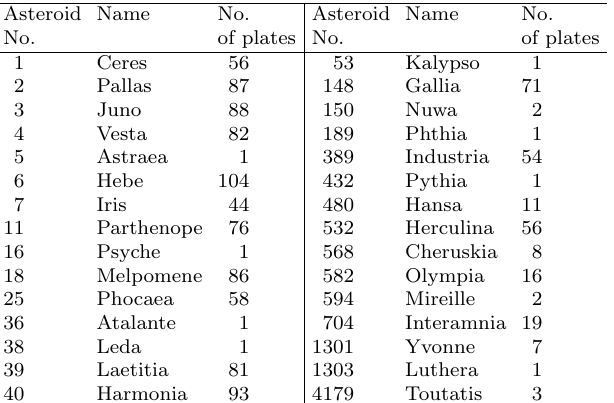
Table 1. The list of